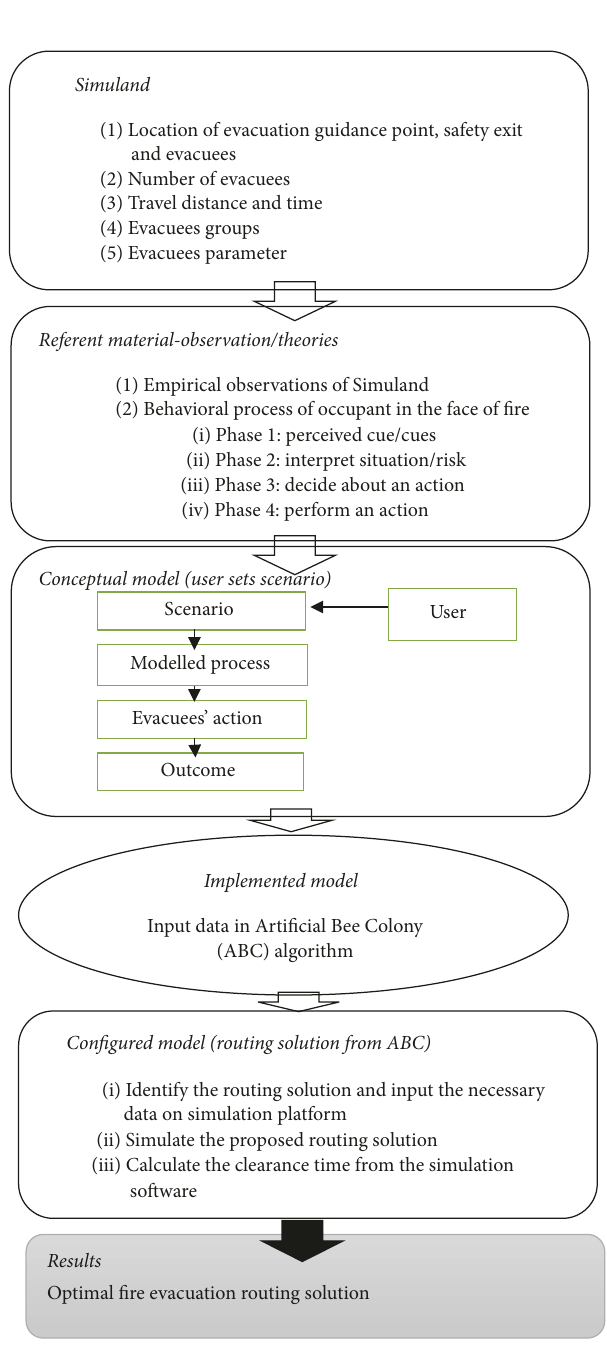
Figure 1: Framework of steps in fireevacuation routing model “Bee-